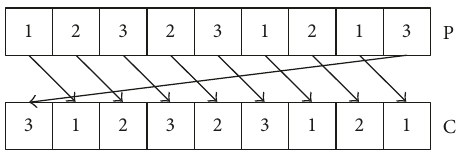
Table 4: Comparison of the initializing population